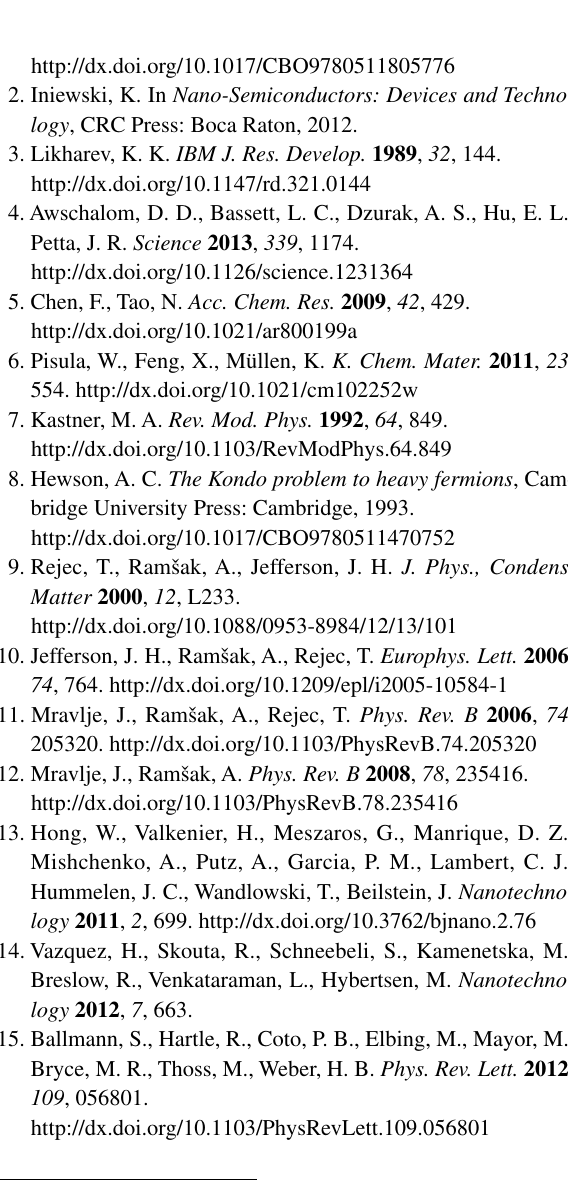
Figure 4. Magic ratios at T = 0 of the (a) benzene, (b) naphthalene, and (c) anthracene molecule when the on-site energies ε where the electrodes are attached differ from those at other molecular sites where ε re Γ = γ 1